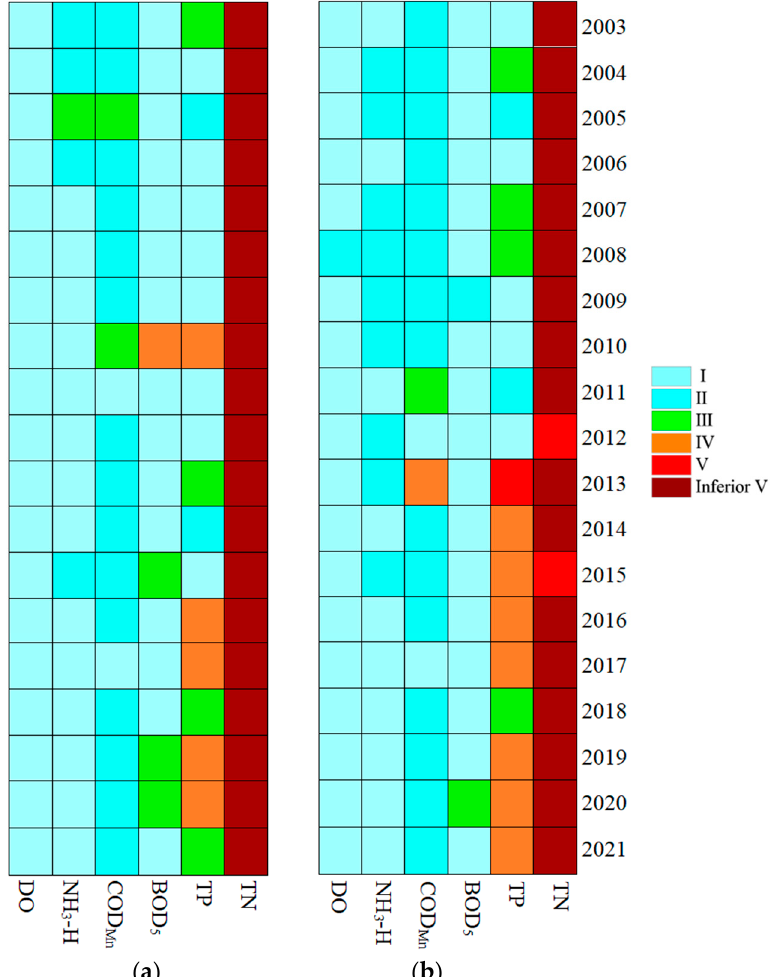
Figure 3. Water quality evaluation results for each indicator of the Beizamu section from 2003 to 2021. ( a ) low water period (May), ( b ) high water period (September).